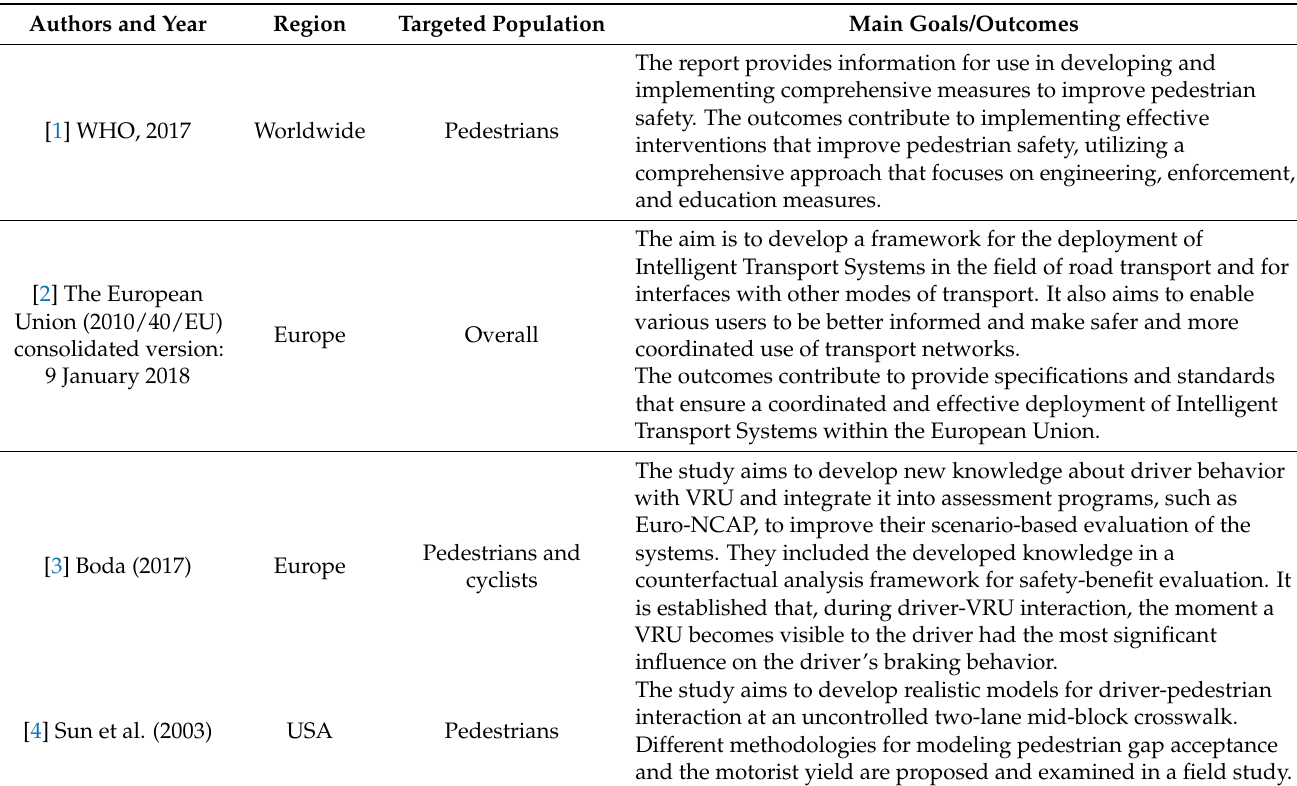
Table A1. Characteristics of eligible studies by region, type, and main goals and